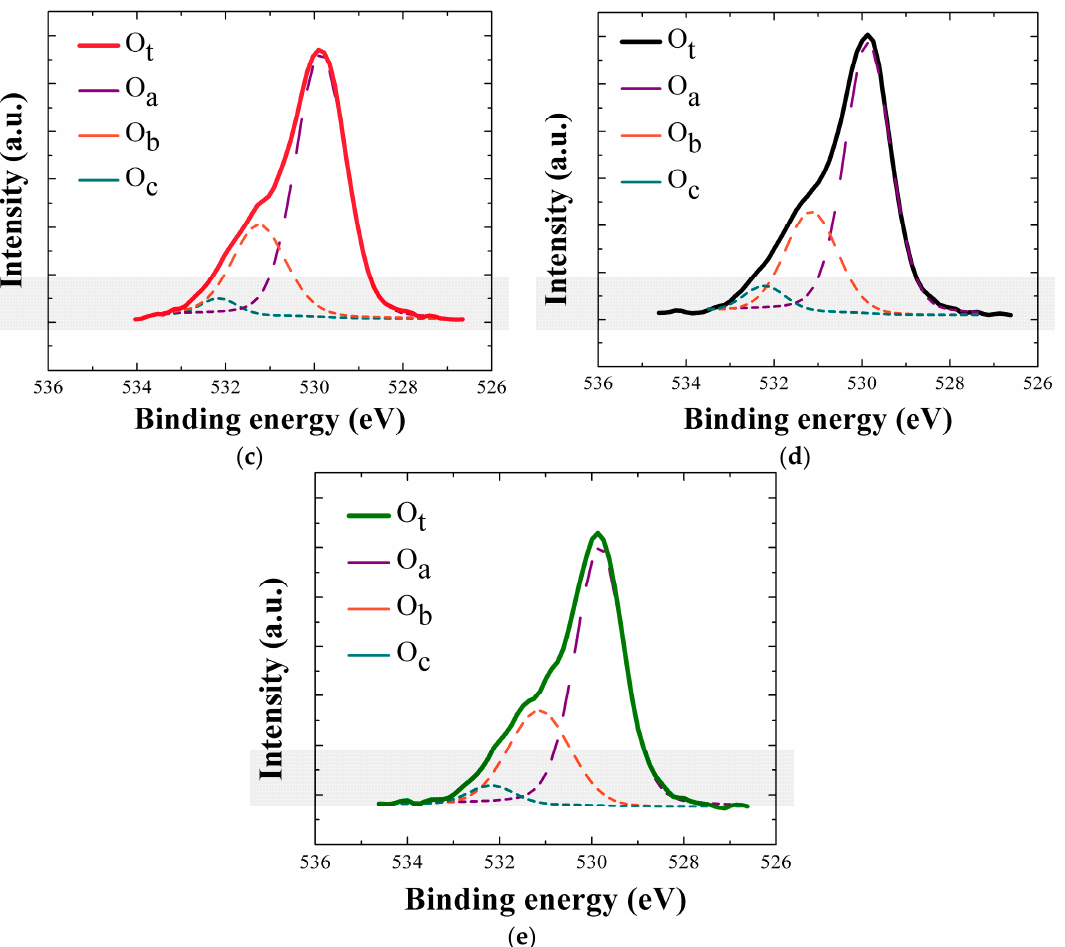
Figure 7. ( a ) Wide scan XPS spectra of ZnO NRs grown on SLs annealed in three different ambients; ( b ) High resolution spectra of Zn-2p of the NRs; O1s core level spectra obtained from the ZnO NRs grown on SLs annealed in ( c ) vacuum; ( d ) air, and ( e ) nitrogen ambient are de-convoluted into three distant satellite peaks.